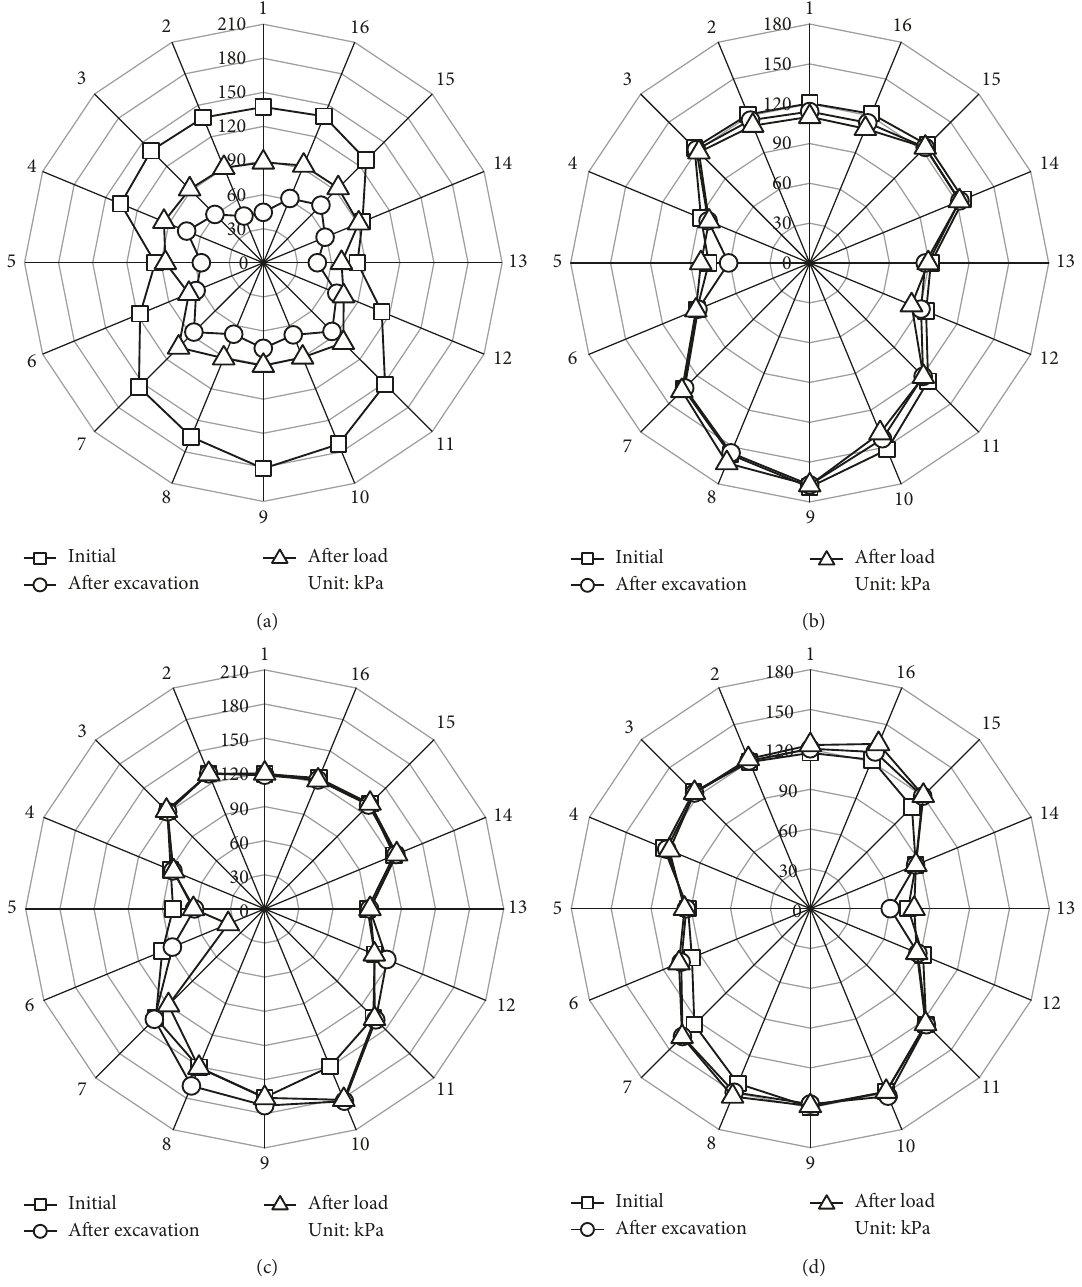
Figure 6: Surrounding earth pressure on the tunnel. (a) Scheme 1. (b) Scheme 2. (c) Scheme 3. (d) Scheme